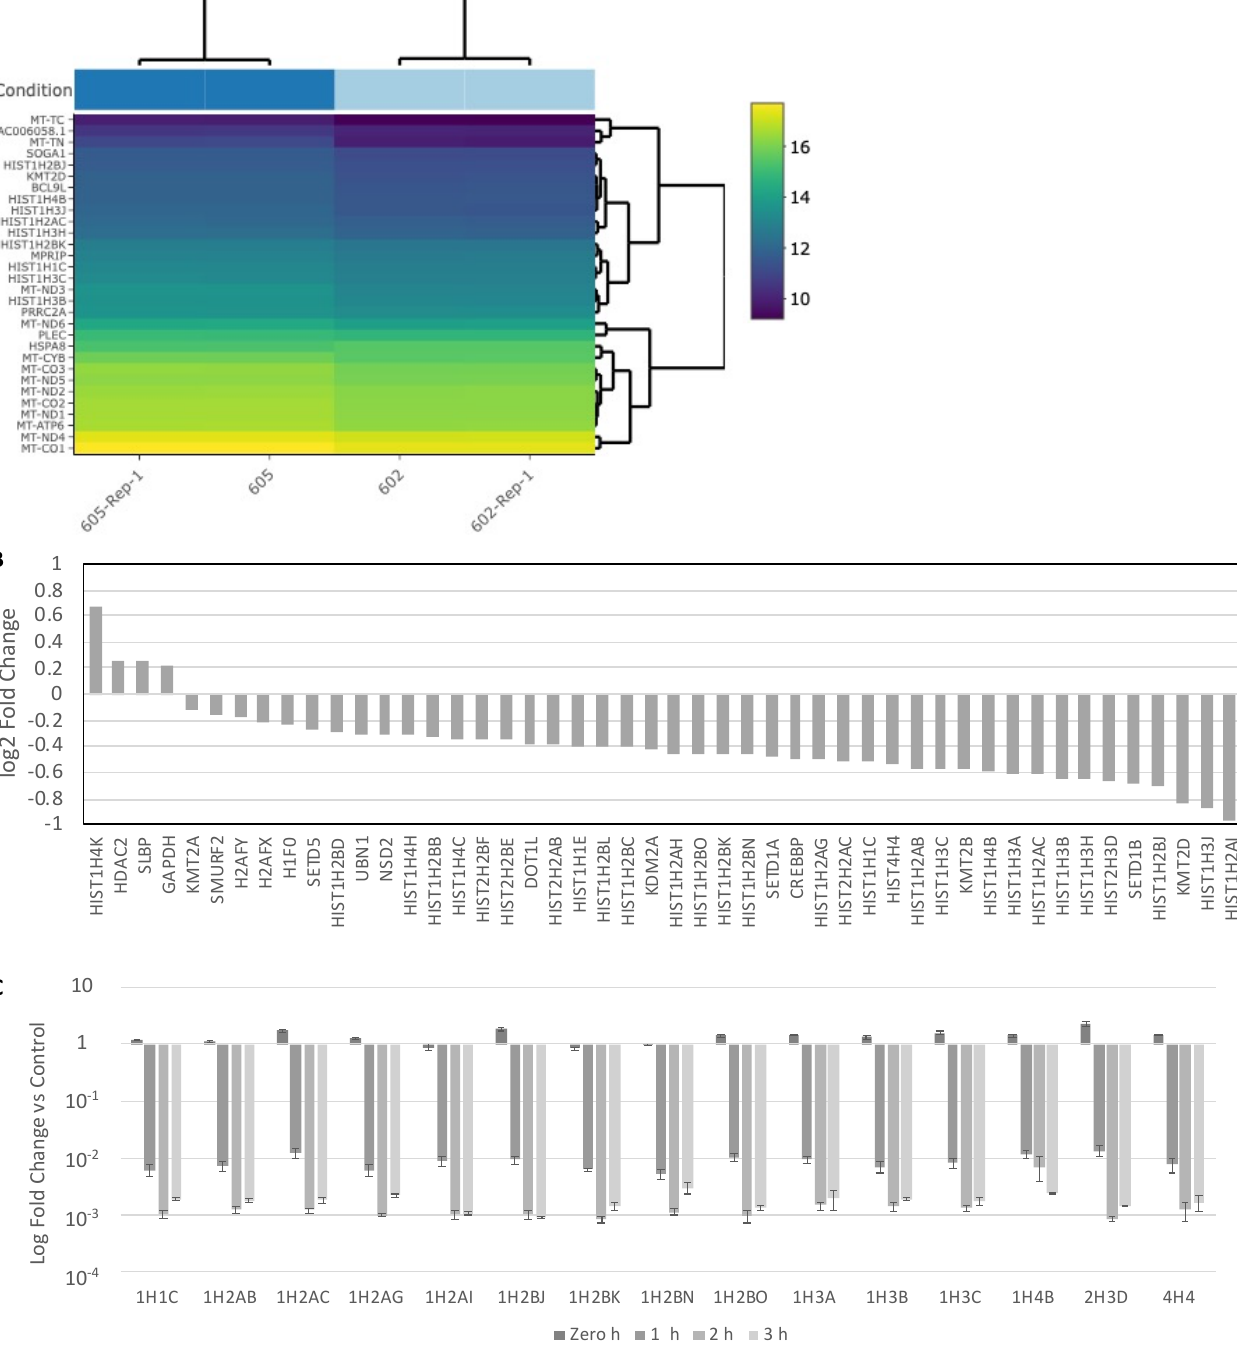
Figure 5. ( A ) Heatmap of the top 30 differentially expressed genes between CHCP-treated MDA-MB-231 cells (602) and mocks (605). Gene expression levels are displayed on a log (absolute values) scale. ( B ) Next-generation sequencing (NGS) whole-transcriptome analysis in fold-changes (log2 scale) of histone and histone-related transcripts after 6 h CHCP treatment in MDA-MB-231 cells. ( C ) Histone mRNA degradation after CHCP treatment. Fold-change of histone mRNA after 0, 1, 2 and 3 h post-treatment compared to mock control samples of MDA-MB-231 cells.